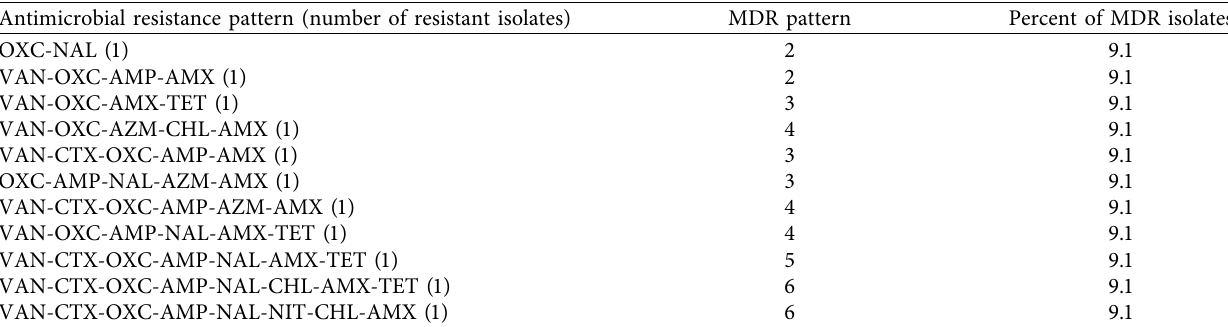
Table 7: Multidrug resistance patterns of L. monocytogenes isolates ( N � 11). Antimicrobial resistance pattern (number of resistant isolates)